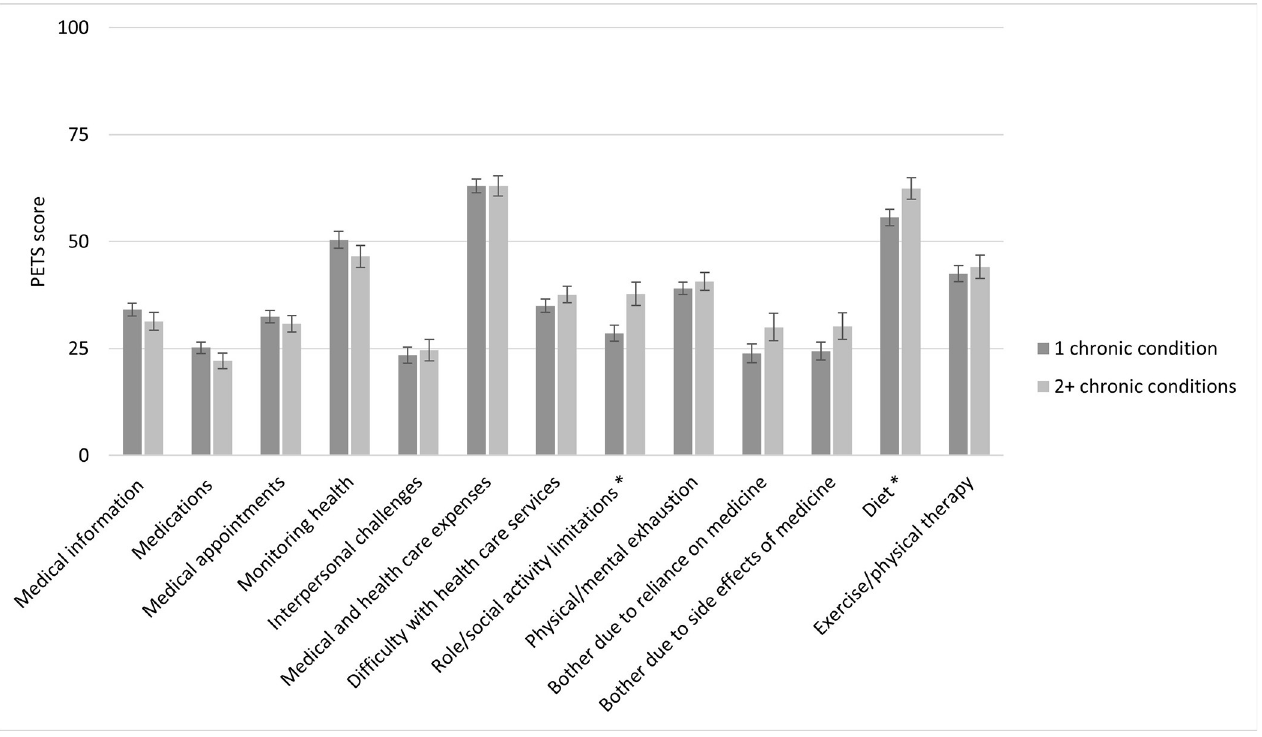
Fig 2. PETS scores by number of chronic conditions, total sample. Note. � role/social activity limitations: p = 0.005; diet: p = 0.030. See also S7